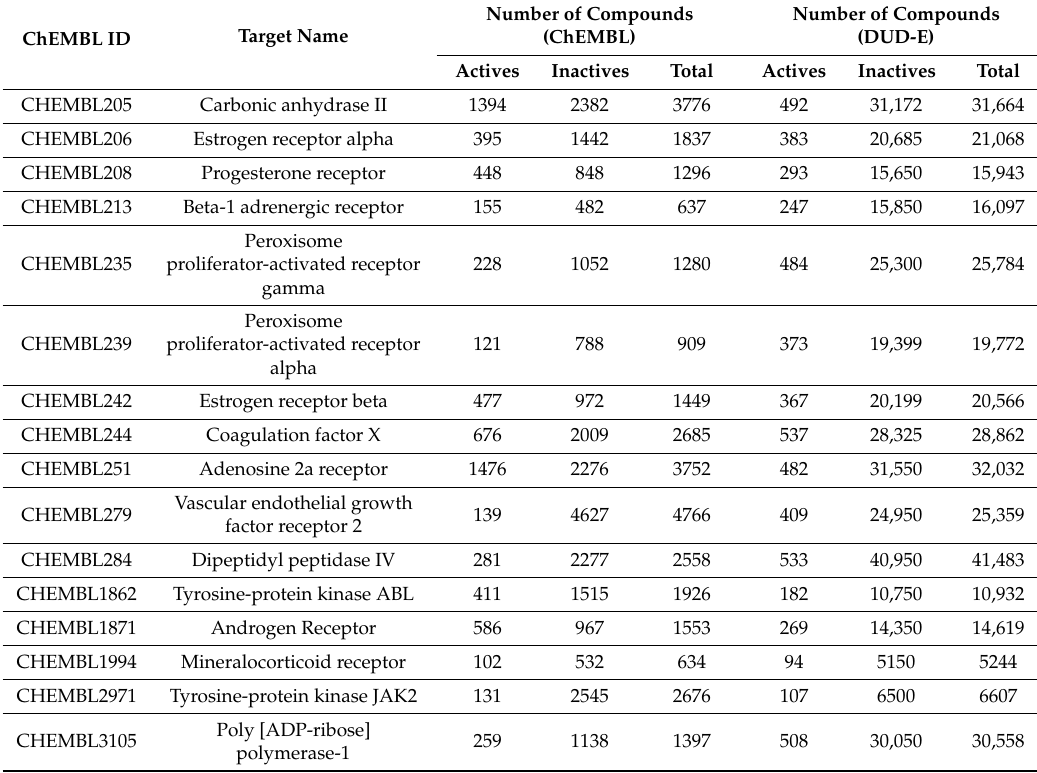
Table 1. ChEMBL datasets used for ligand-based pharmacophore modeling and calibration and DUD-E dataset used for external